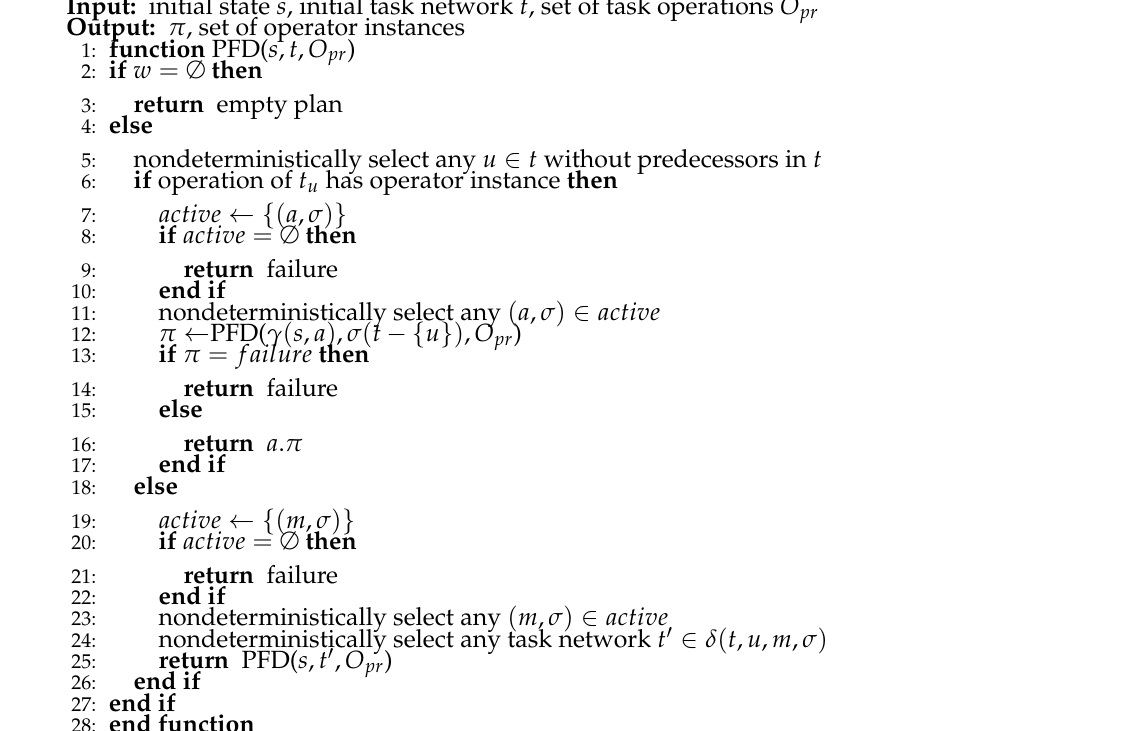
Algorithm 1: Algorithm for the partial-order Markov task network